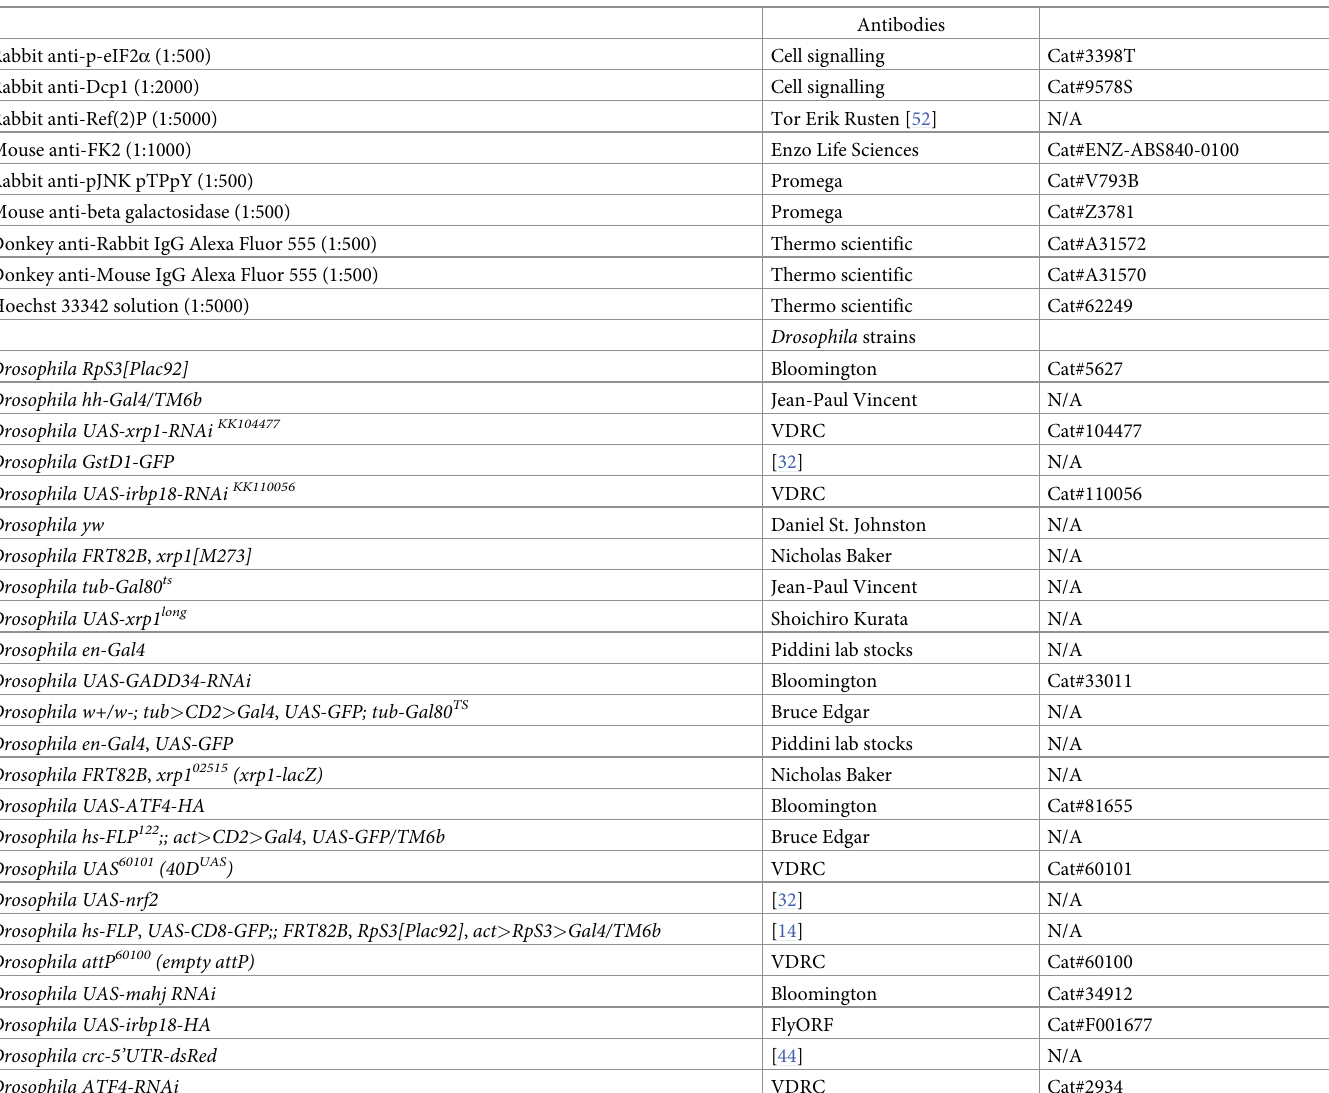
Table 2. Key Resources